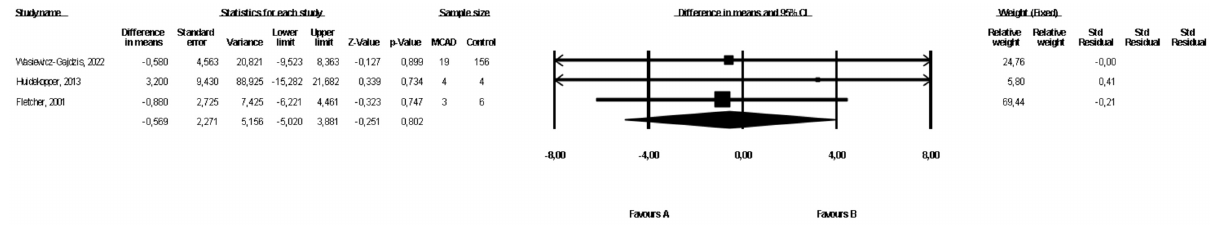
Figure 3. Forest plot—comparison of BMI in FAOD patients vs. controls [14,15,17–20,25].